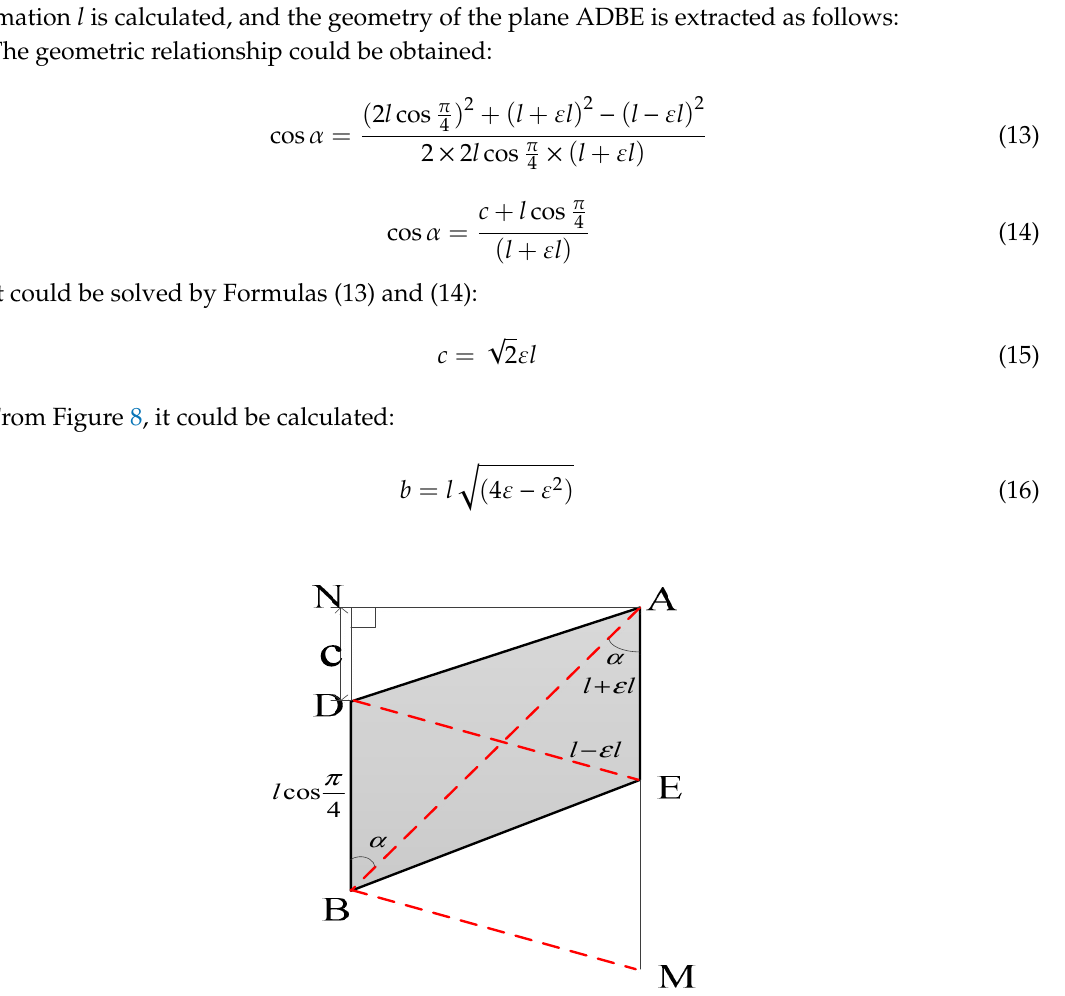
Figure 8. Schematic diagram of fiber Bragg gratings.